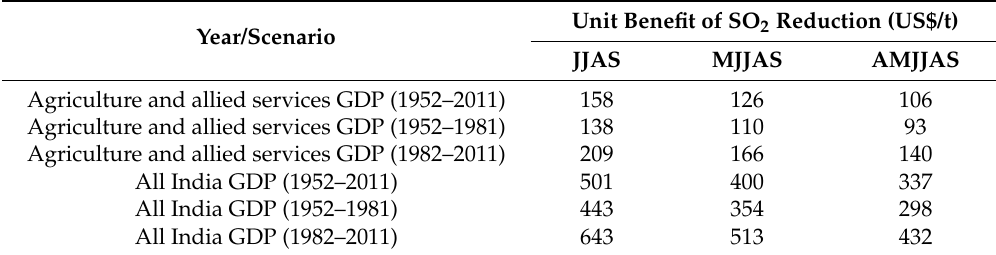
Table 6. Unit benefit of SO 2 emissions reduction for the whole Indian economy and the subset of Agriculture and allied services based on the quadratic relationship between ISMR and GDP, for the years 1952–2011 and 1982–2011 and for three different scenarios of the period in which SO 2